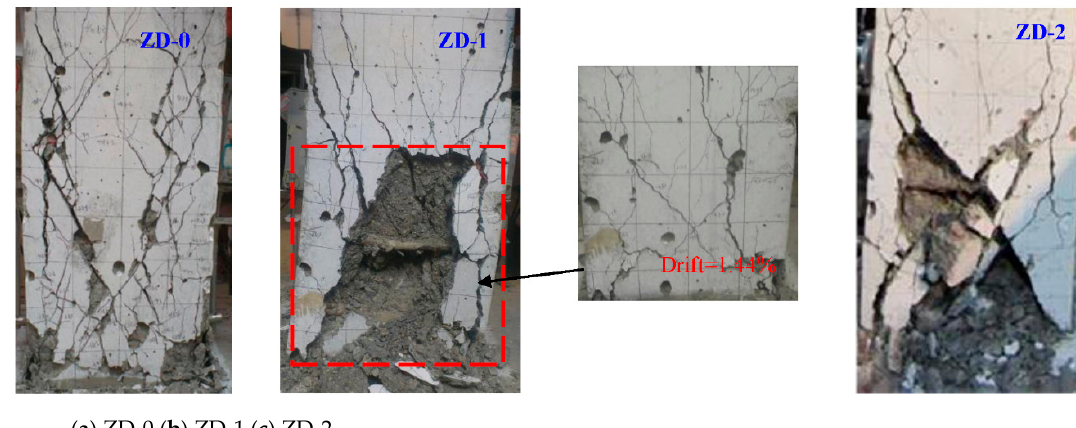
Figure 7. Failure status of specimens.